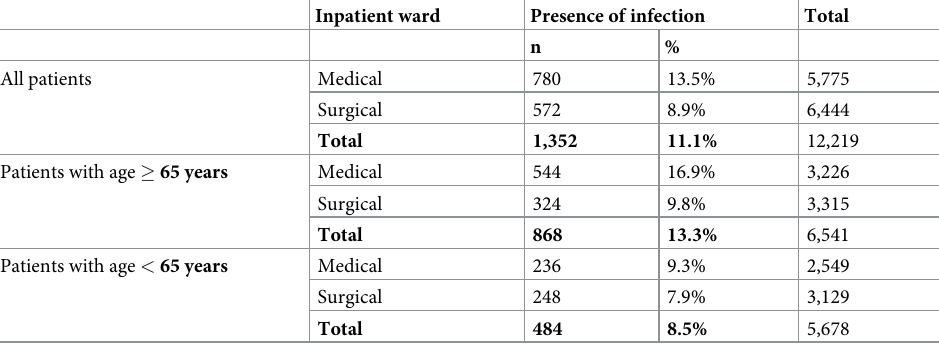
Table 3. Distribution of HAI microorganisms by ward type.